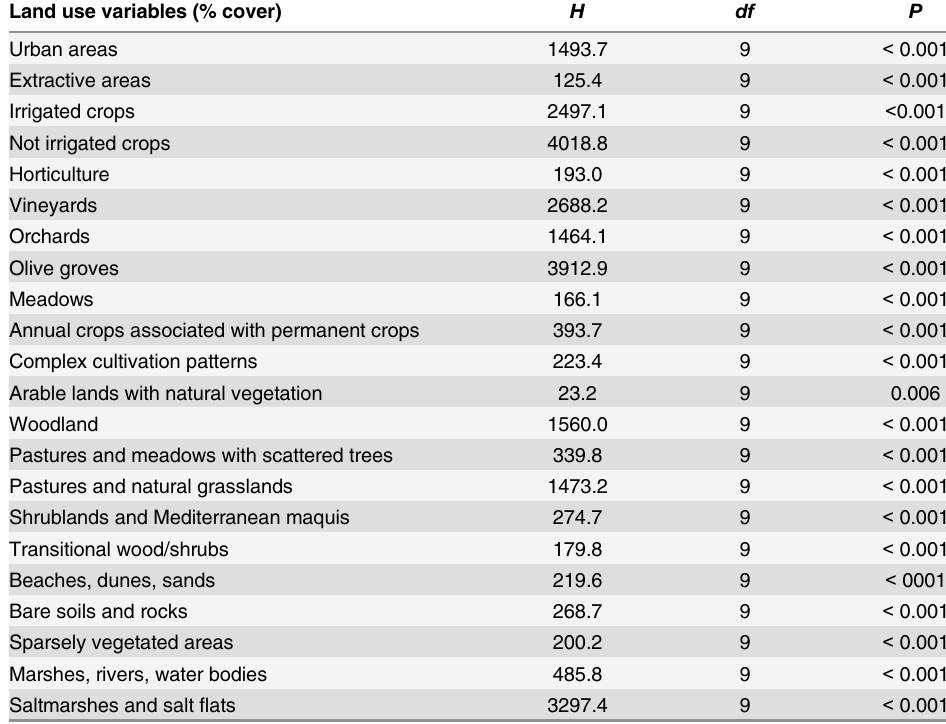
Table 1. Land use classes with significant differences between the Landscape Units obtained by the cluster analysis (Kruskal-Wallis test). Land use variables (% cover) H df P Urban areas